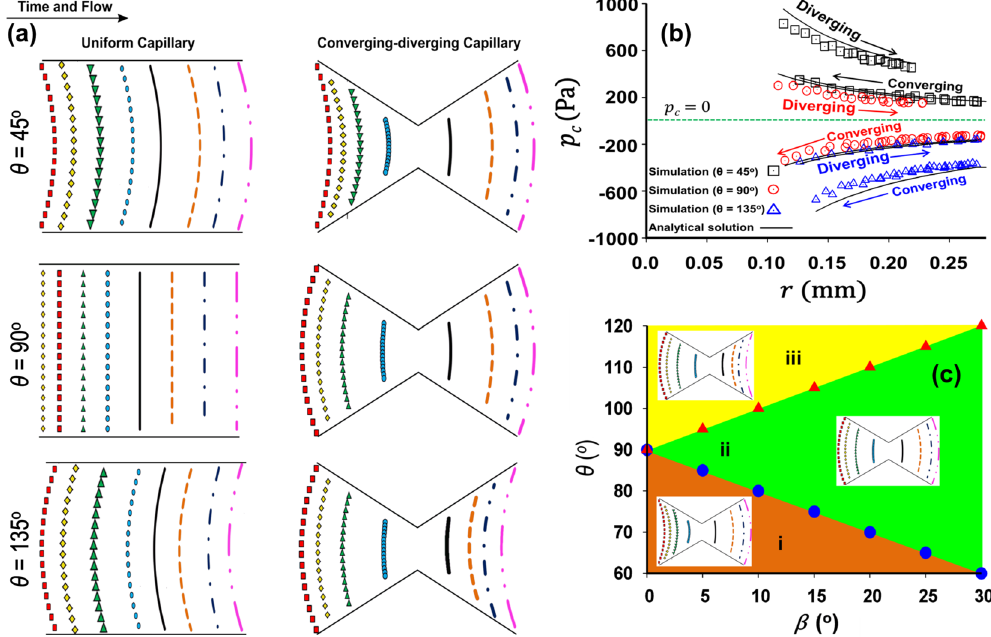
Figure 2. ( a ) Movement of the fluid-fluid interface in uniform and converging-diverging capillaries at different contact angles θ . Colour lines denote the position of the interface at the vertical plane of symmetry of the 3D capillaries (see Fig. 1). In the uniform capillary, the interface is simply translated, maintaining its shape and curvature for all values of θ . In the non-uniform capillary, in contrast, the shape of the interface changes between the converging section and the diverging section of the capillary. This change is particularly notable for θ = 90°: there is a transition in the interface curvature from concave to convex as the interface moves from the converging to the diverging section. ( b ) Evolution of capillary pressure p c (Pa) as a function of the local capillary radius r , as the interface moves from the converging to the diverging section of the capillary, for different values of θ . In drainage ( θ = 45°, black squares), the interface is convex along the entire capillary, and p c > 0. In imbibition ( θ = 135°, blue triangles), the interface is concave throughout, and p c < 0. In the neutral wetting case ( θ = 90°, red circles), in contrast, the interface is concave in the converging section ( p c < 0), and convex in the diverging section ( p c > 0), illustrating the contribution of the capillary angle β in modulating p c . ( c ) Phase- diagram in θ – β space, separating the region where the apparent wettability switches from wetting to nonwetting as a result of pore geometry ((ii) shaded green), to the regions that remain uniformly wetting ((i) shaded brown) and nonwetting ((iii) shaded yellow). The boundaries between regions correspond to the values for which the interface is flat in the converging section ( θ = π /2 − β , blue circles) and in the diverging section ( θ = π /2 + β , red